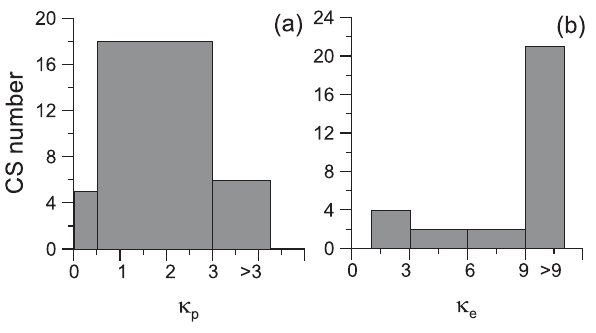
Fig. 8. Distributions of proton (a) and electron (b) adiabaticity pa-